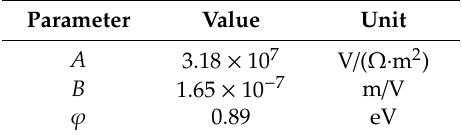
Table 2. Simulation parameters based on the conductivity model.